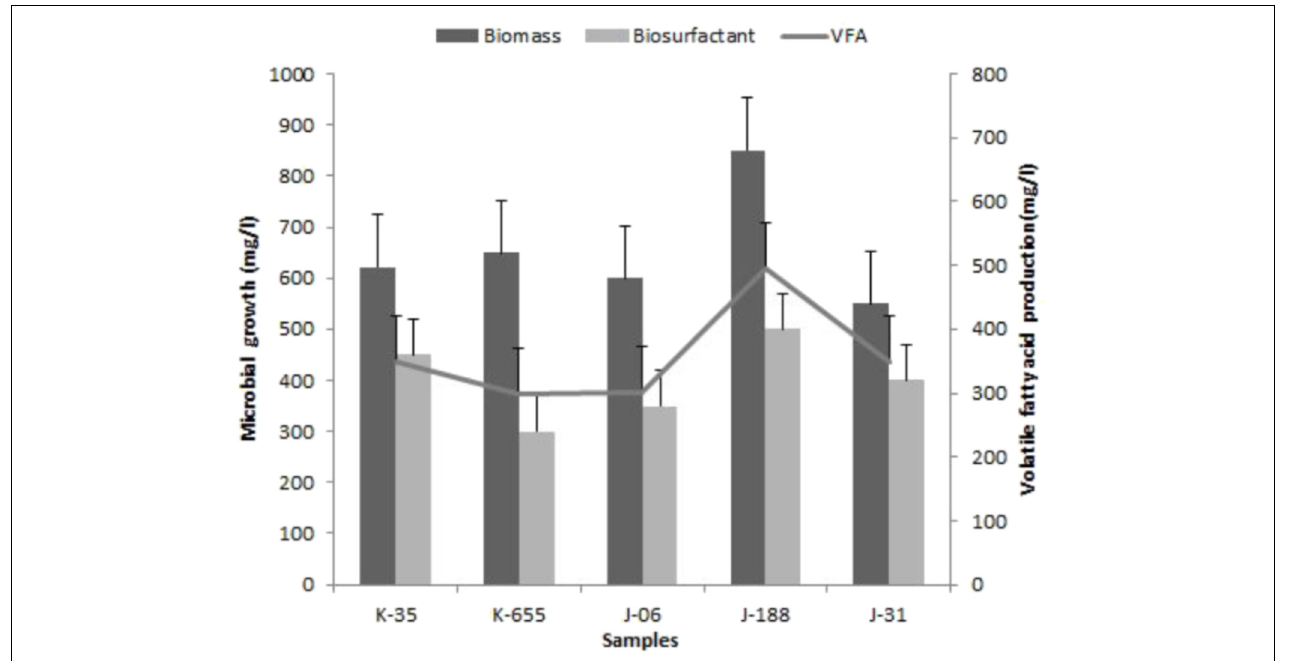
FIGURE 3 | Biomass growth, VFA and bio-surfactant production by isolated consortia K-35, K-655, J-06, J-188, and J-31.